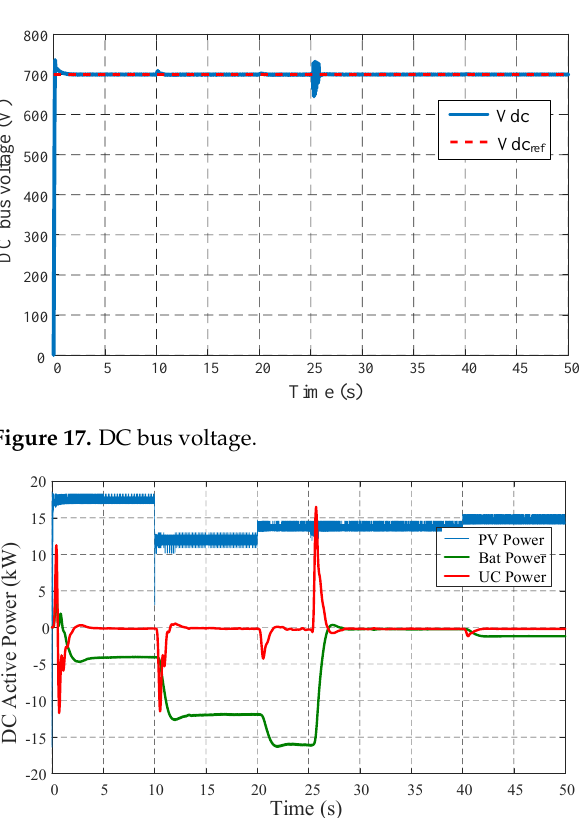
Figure 18. Power output profiles: PV (blue), battery (green), and ultracapacitor (red).